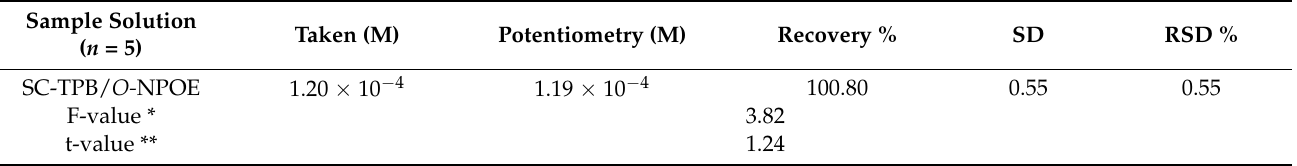
Table 5. Determination of SC in spiked human urine samples using SC-TPB and SC-PTA with PVC plasticized by O- NPOE or